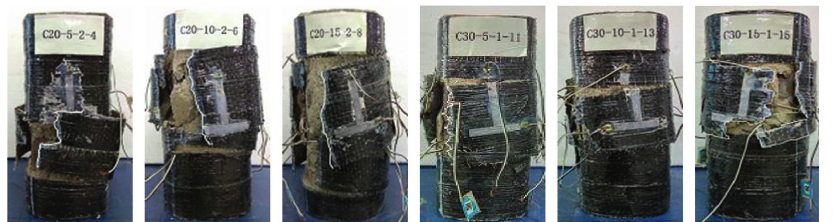
Figure 4: Failure mode of some specimens.